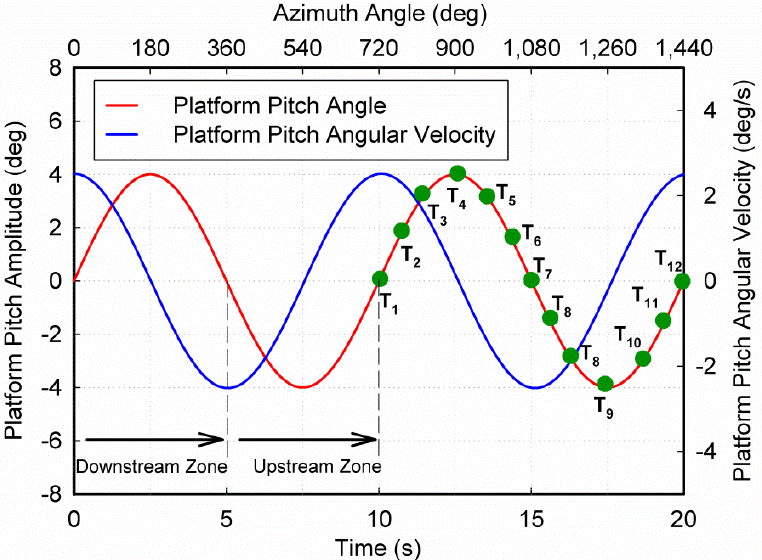
Figure 4. Platform pitching angle profile (Amp = 4.0 deg, Freq = 0.1